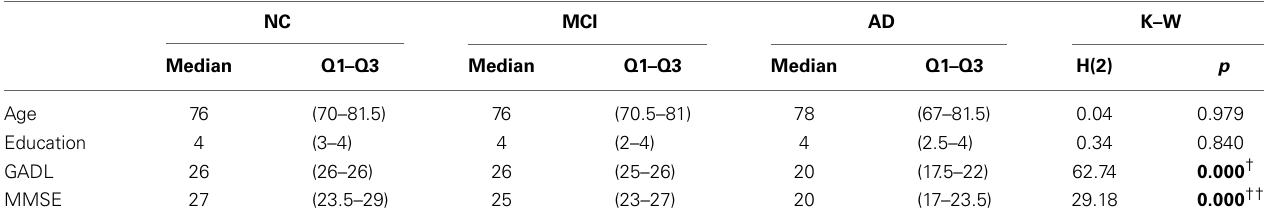
Table 1 | Demographic description of NC, MCI, and AD groups.